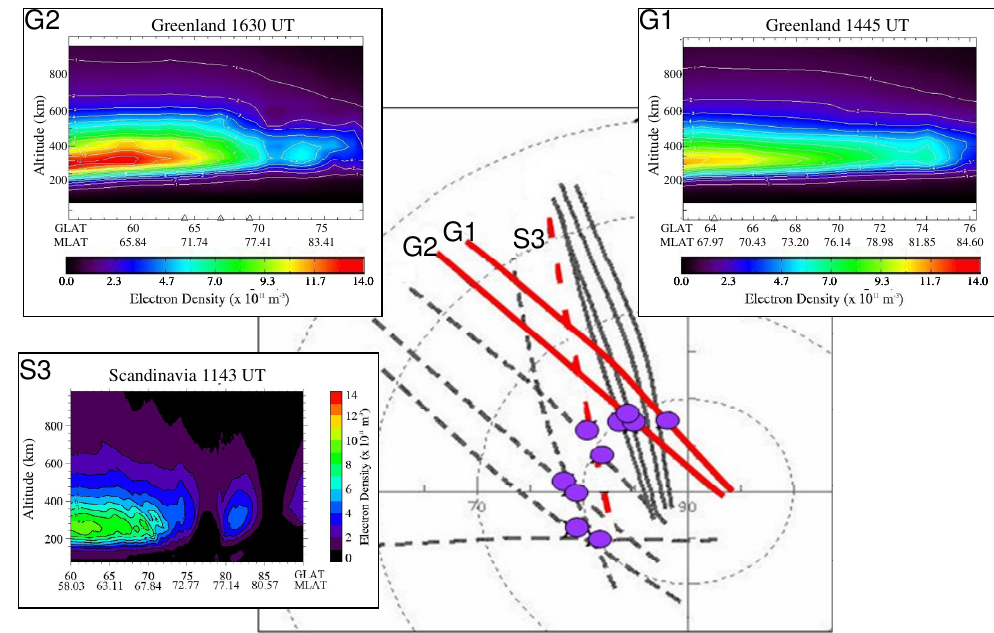
Fig. 8. Three sample tomography reconstructions for 14:45UT (Greenland), 16:30UT (Greenland) and 11:43UT (Scandinavia) on 26 November 2001. The trajectories of the corresponding three satellite passes are shown in red in the centre panel on a MLAT versus MLT polar plot. The locations of the electron density feature detaching from the main photoionisation for these reconstructions and another seven reconstructions (not shown) are indicated by the purple dots in the centre panel.